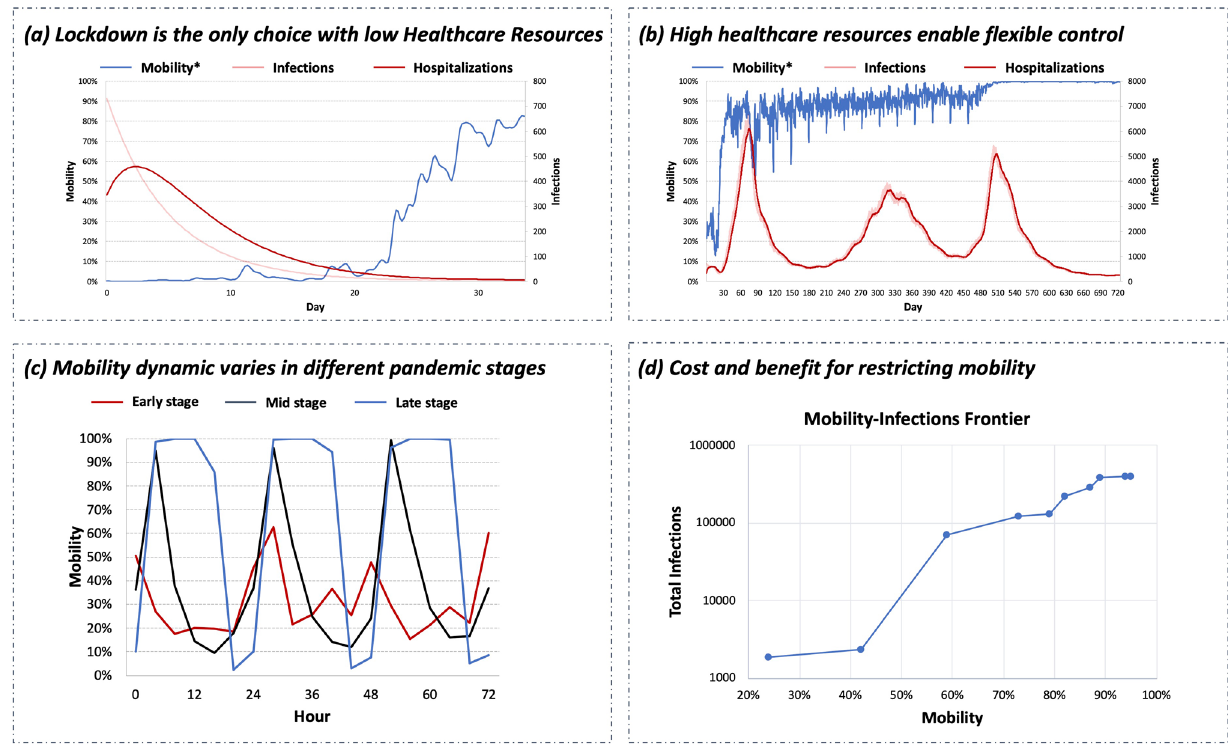
Figure 3. ( a )/( b ) The control extents and pandemic statistics of two example policies that react differently according to different given health care resources; Mobility* refers to the smoothed mobility. ( c ) Dynamic mobility restrictions of city lockdown with high health care resources in the early stage, mid-stage, and late stage of the pandemic; for each stage, we demonstrate control actions in three example days. ( d ) The trade-off relationship between mobility retention and infection